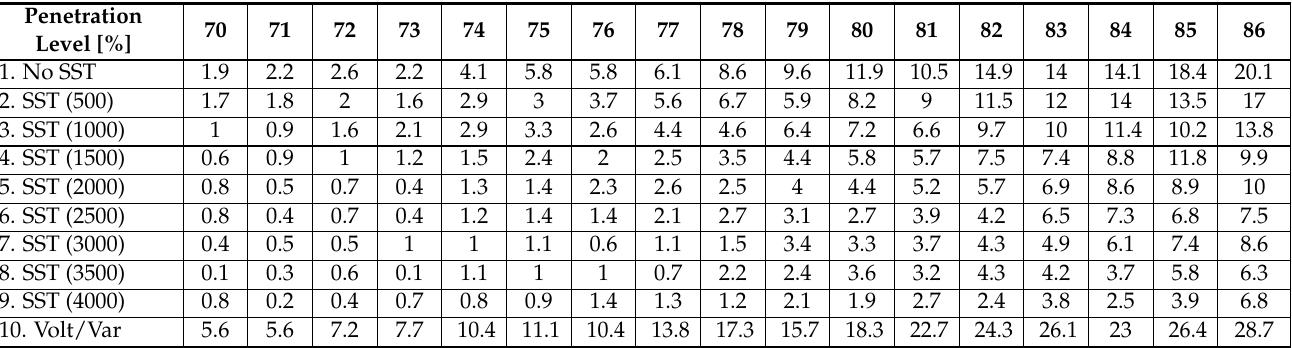
Table 3. Probability of violation for each